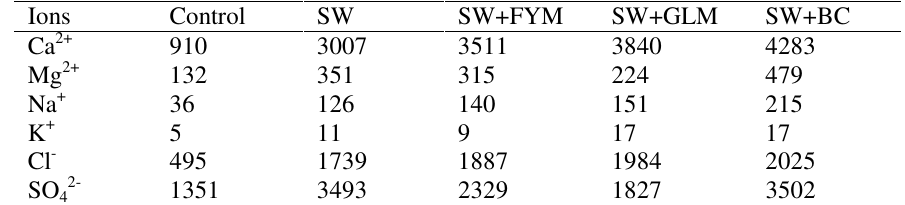
Table 3 . Effect of spentwash and organic amendments on total amount (mg) of cations and anions leached from calcareous